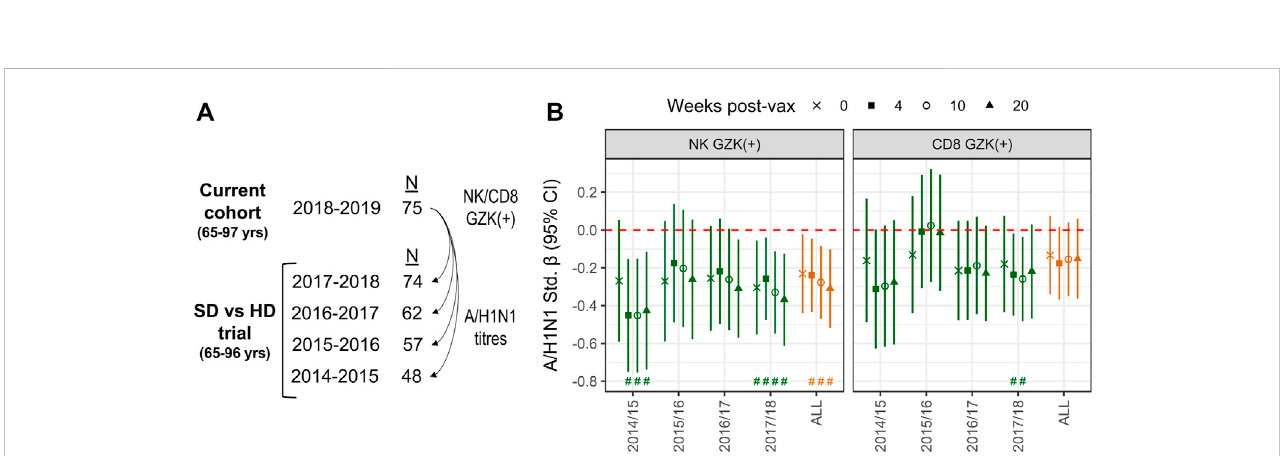
FIGURE 5 GZK-expressing NK- and CD8 T-cell frequency is inversely associated with prior A/H1N1 antibody titres in older adults. (A) Participants enrolled in the current cohorthad also been enrolled inmultipleyearsofapreviousrandomized vaccinetrial, inwhich A/H1N1antibodytitres against thevaccinestrain were measured. (B) Associations for standardized log A/H1N1 antibody titres measured at baseline (i.e., 0) and 4-, 10-, and 20-week post-vaccination, obtained for eachyear oftherandomized trialorall yearscombined, with standardizedlog GZK+NK-cellor CD8 + T-cell frequencies obtained in2018/19.Models for individual years were adjusted for age, sex, vaccine dose, and site of enrollment, whereas models for all years combined were adjusted for age, sex, dose and randominterceptsfor site,participant andyearofstudy.Nooverlapofthe95%CI withthereddottedlineindicates signi fi cance atthenominallevel, whilethe ‘ # ’ indicates that signi fi cance was maintainted at an FDR adjusted p <